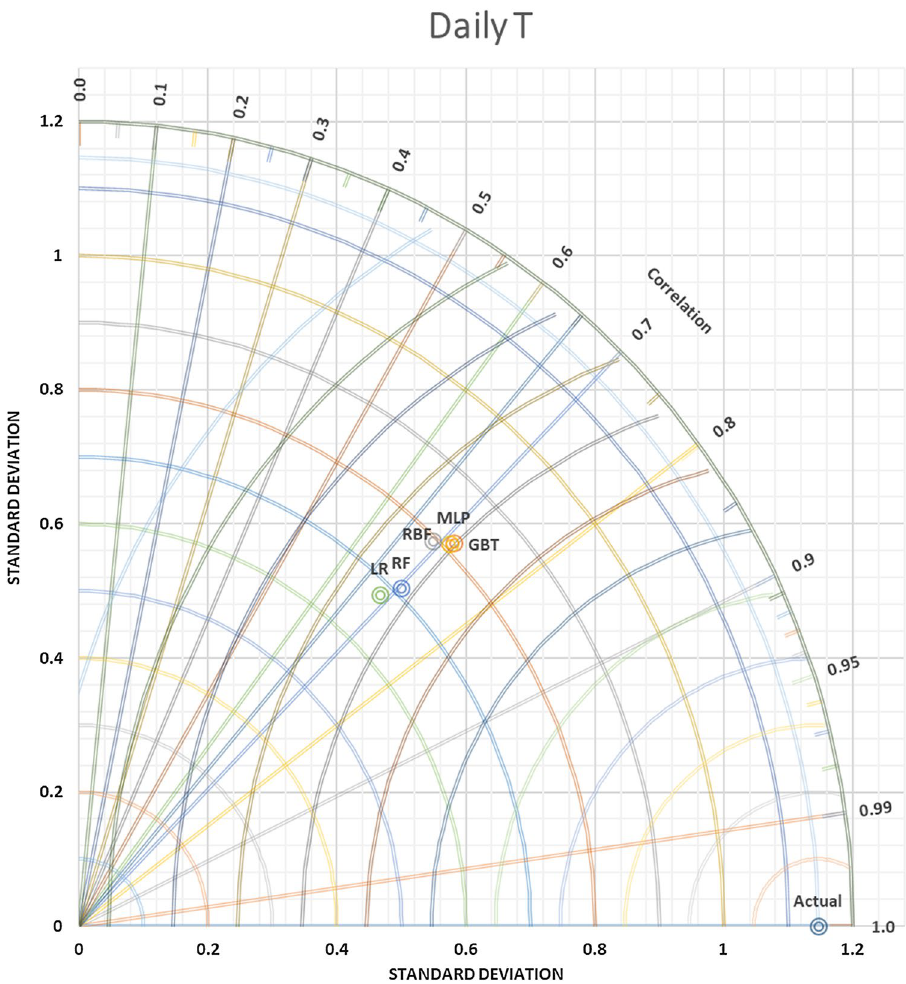
Figure 9. Taylor diagram of predicting daily T amounts using the most accurate